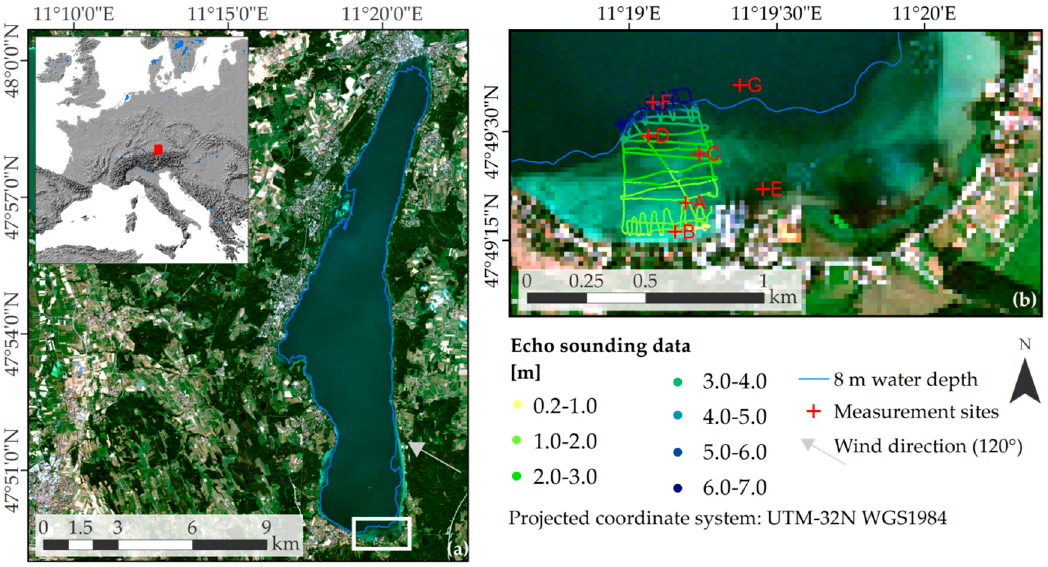
Figure 1. S2-A true-colour composite (R-G-B: 665 nm-560 nm-490 nm, 13 August 2015, 10 m) of Lake Starnberg, Germany ( a ) and location of measurement sites ( b ).